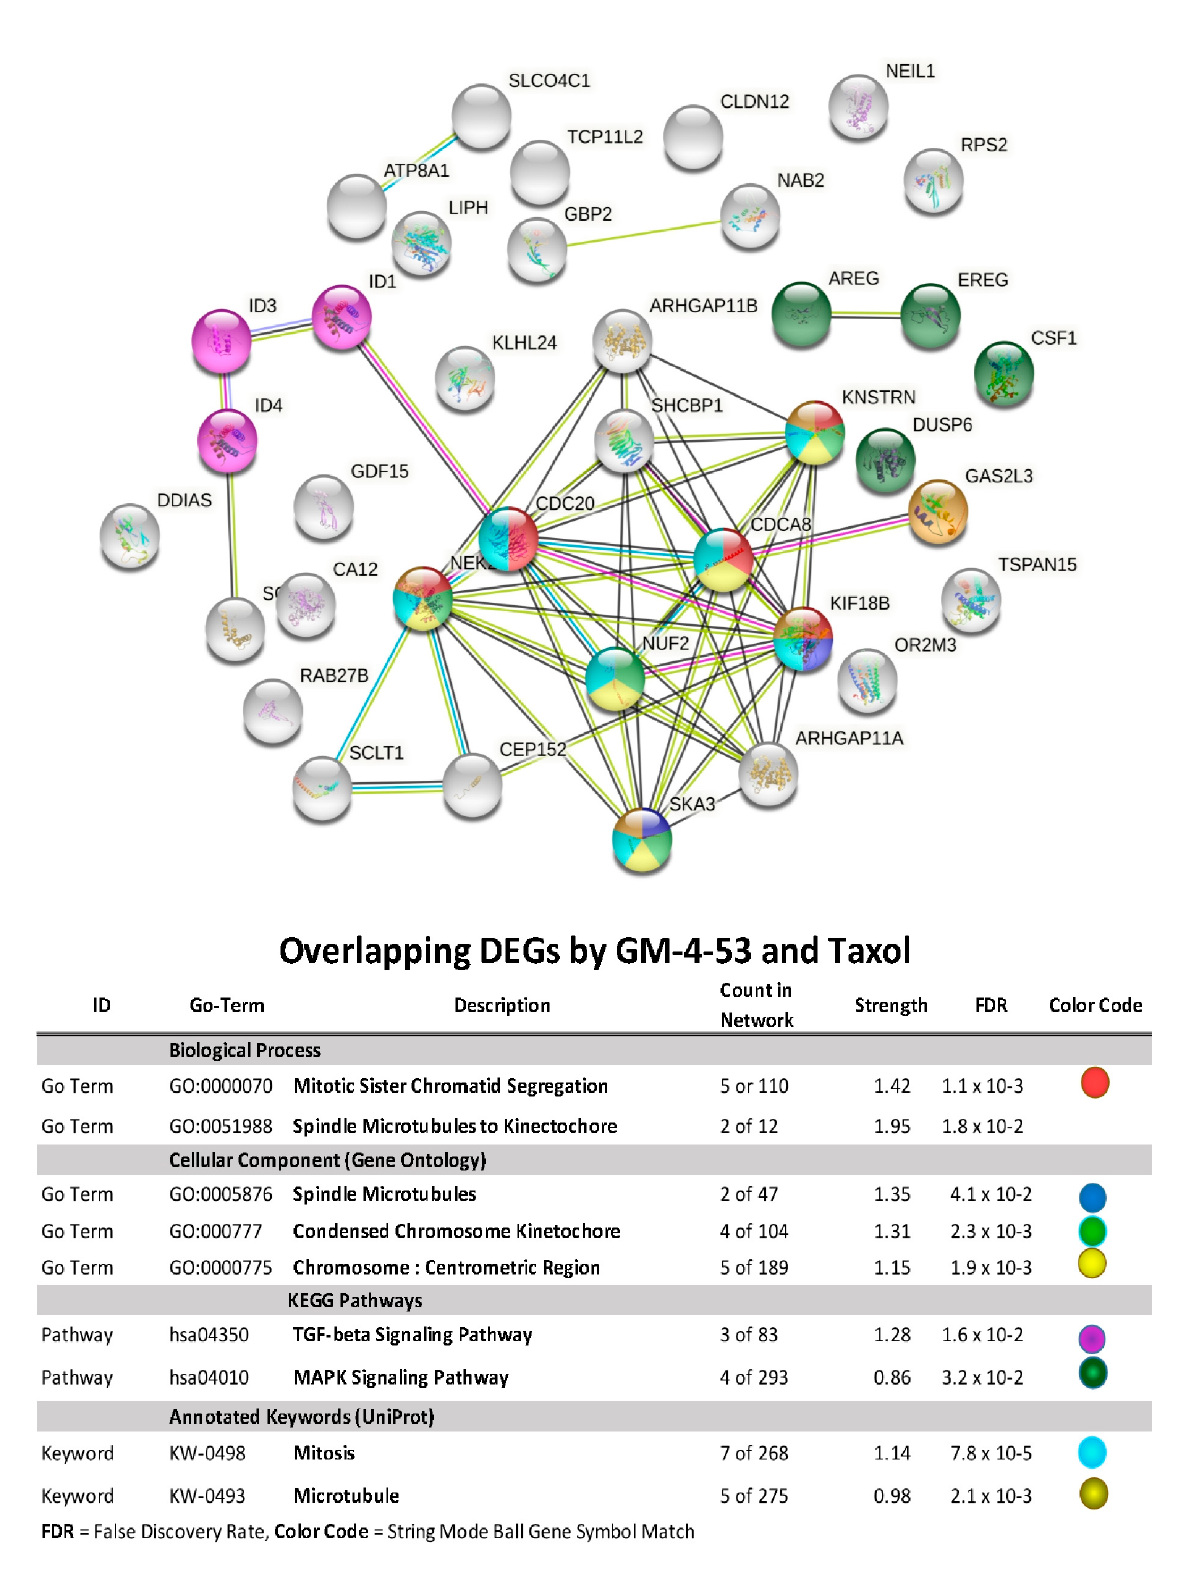
Figure 6. Functional analysis of the 52 transcripts overlaps in DEGs by paclitaxel and GM-4-53 vs. controls. The data represent significant functional changes as identified by several databases: local network cluster (STRING), Kegg pathways, Reactome Pathways expected protein domains and feature (Interpore), where data are reflected by count in network, strength, and false discovery rates.